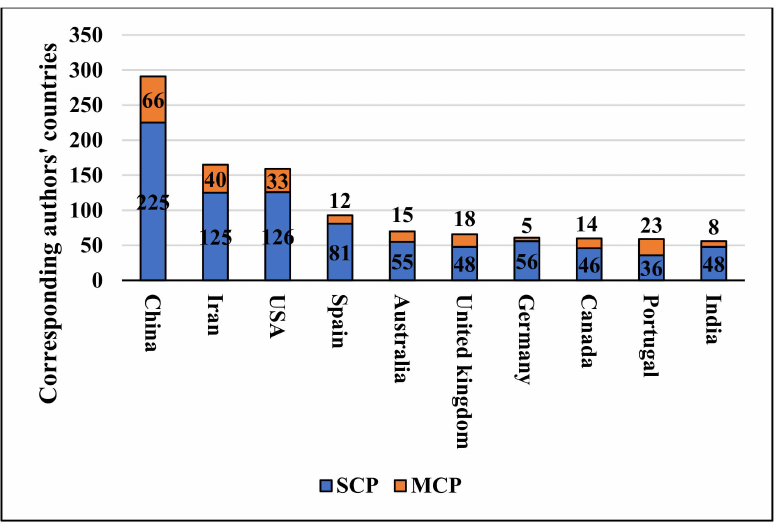
Figure 5. Corresponding authors’ countries. Source: own study using data from